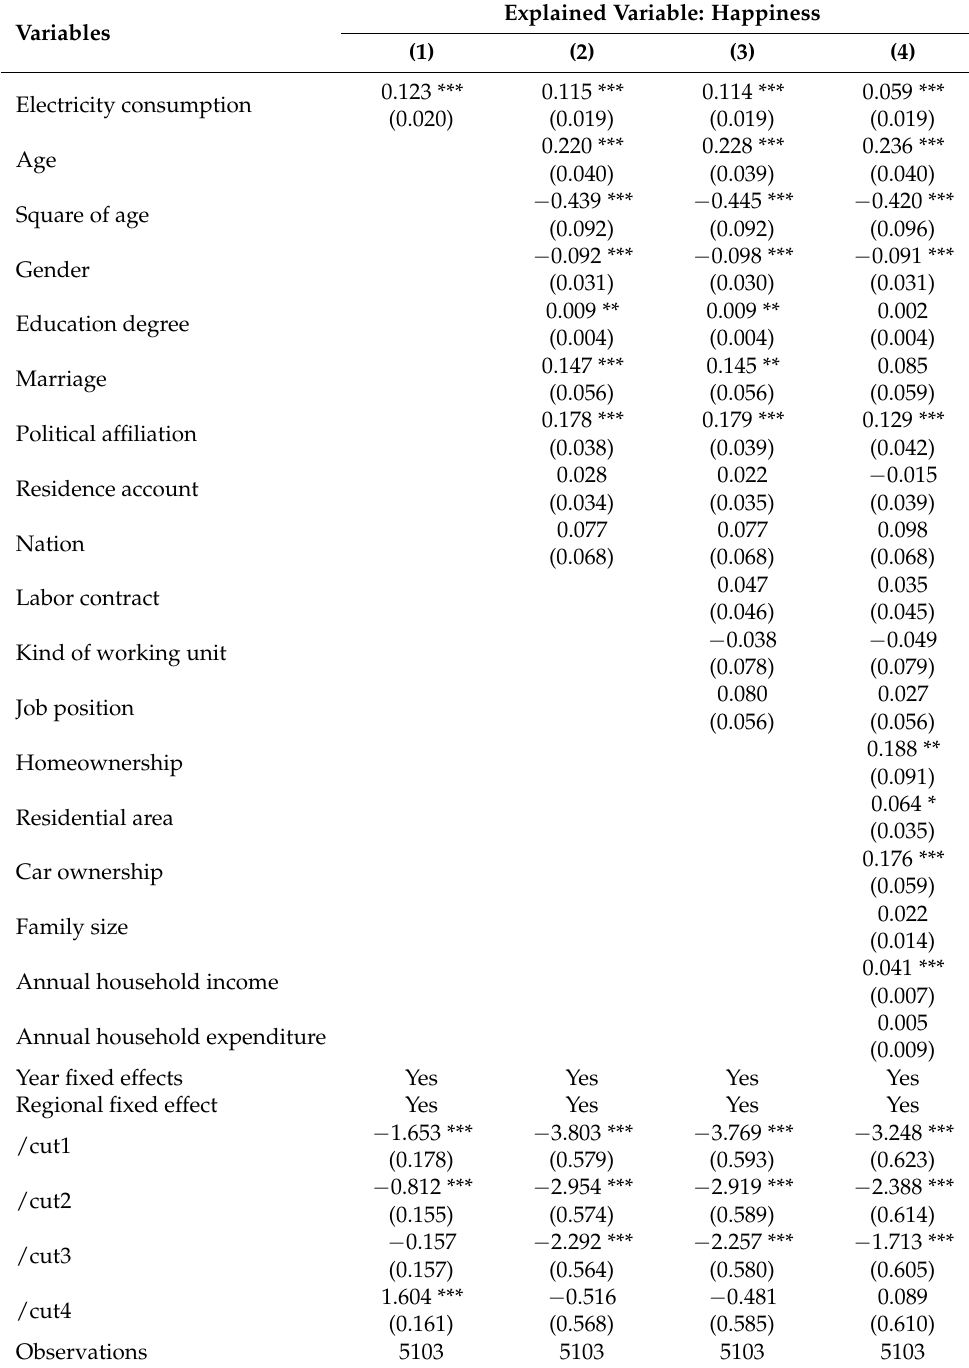
Table 3. Benchmark